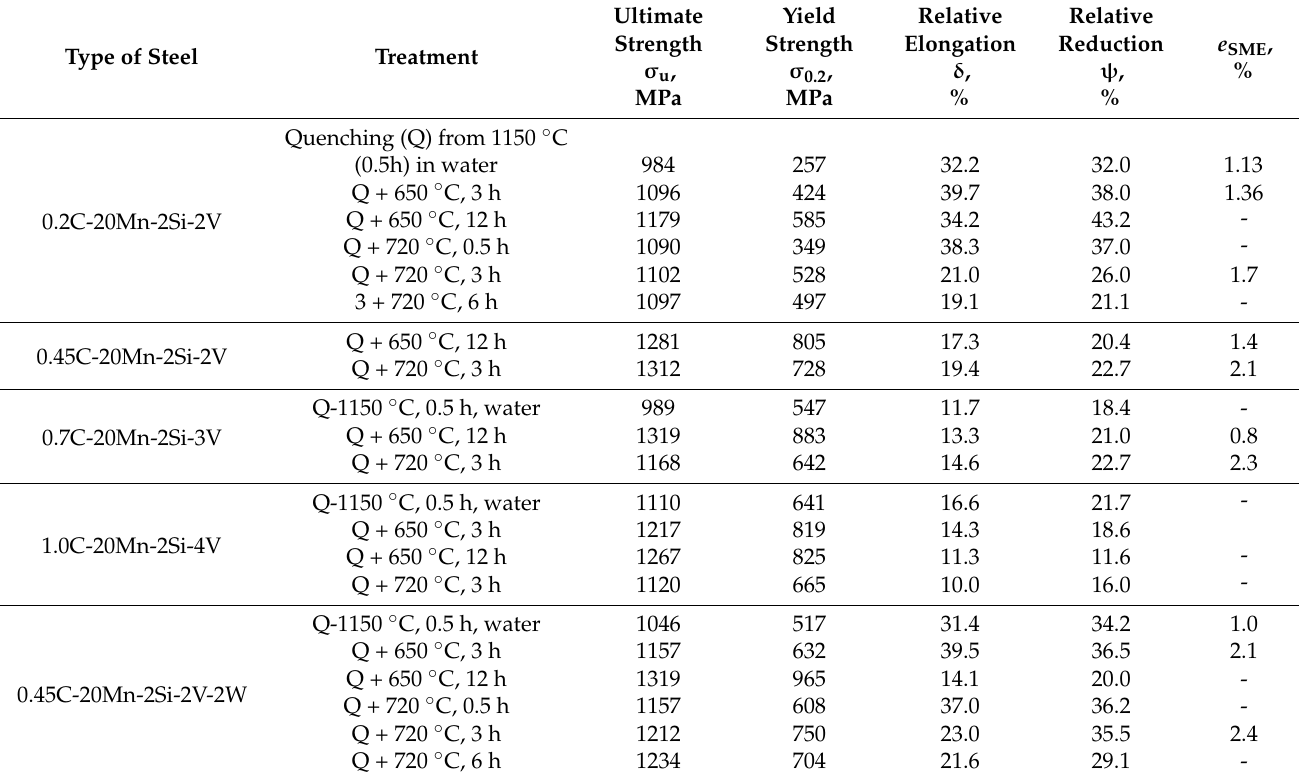
Figure 3. Change in reversible deformation (l, mm, or e , %) in the course of the ε → γ transformation at the heating of the steels 0.7C-20Mn-2Si-3V (curves 1–3) and 28Mn-6Si (curve 4). The preliminary treatment of the steel 0.7C-20Mn-2Si-V: quenching from 1150 ◦ C; aging (for 6h) at (1) 720 ◦ C; (2) 650 ◦ C; and (3) 600 ◦ C; cold deformation via bending e ~ 4%. The initial treatment of the 28Mn-6Si steel: quenching from 1150 ◦ C (curve 4) and cold deformation e ~ 4%. Table 1. Mechanical properties and reversible deformation e SME in Mn-Si-V-C